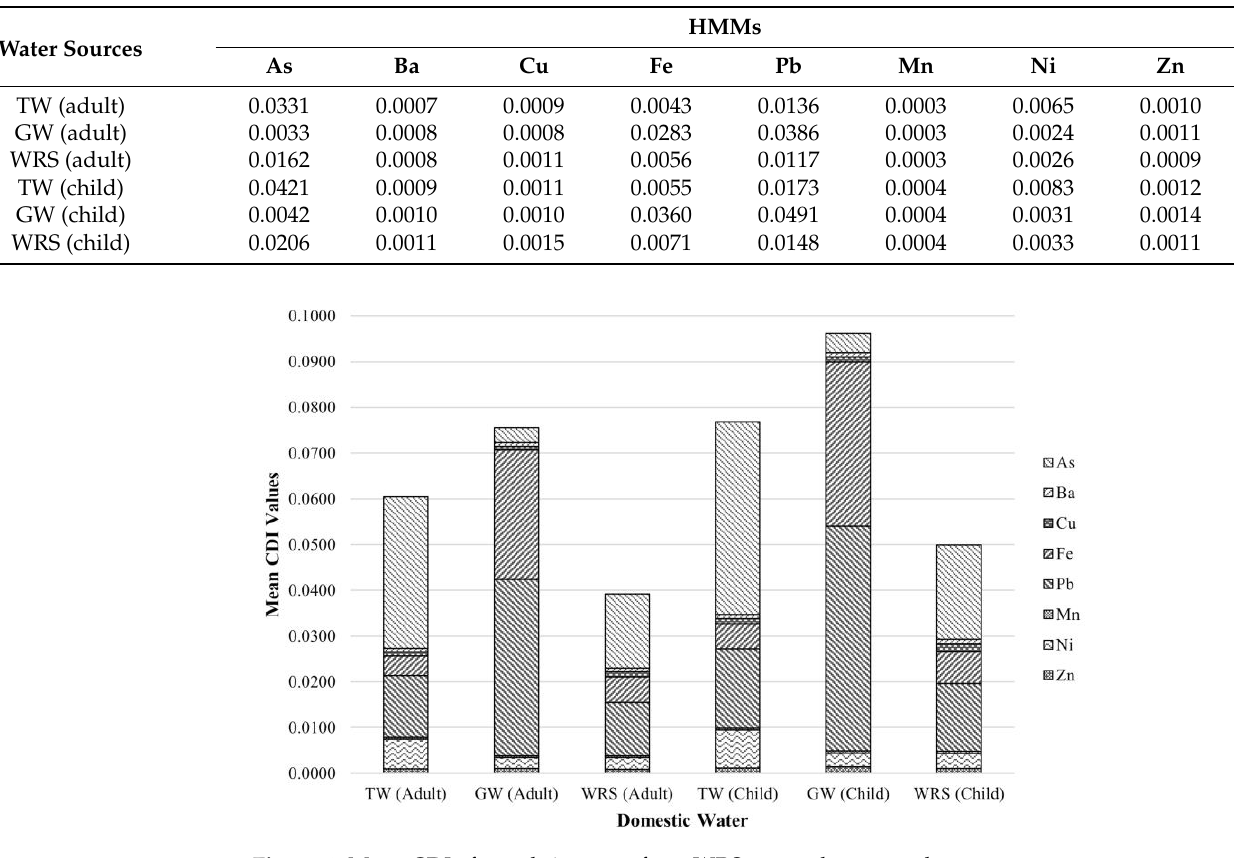
Figure 4. Mean CDI of metals in water from WRS, groundwater, and tap water.